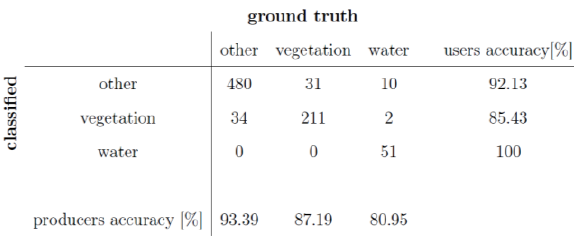
Table 3: Error matrix for accuracy assessment of the land cover classification